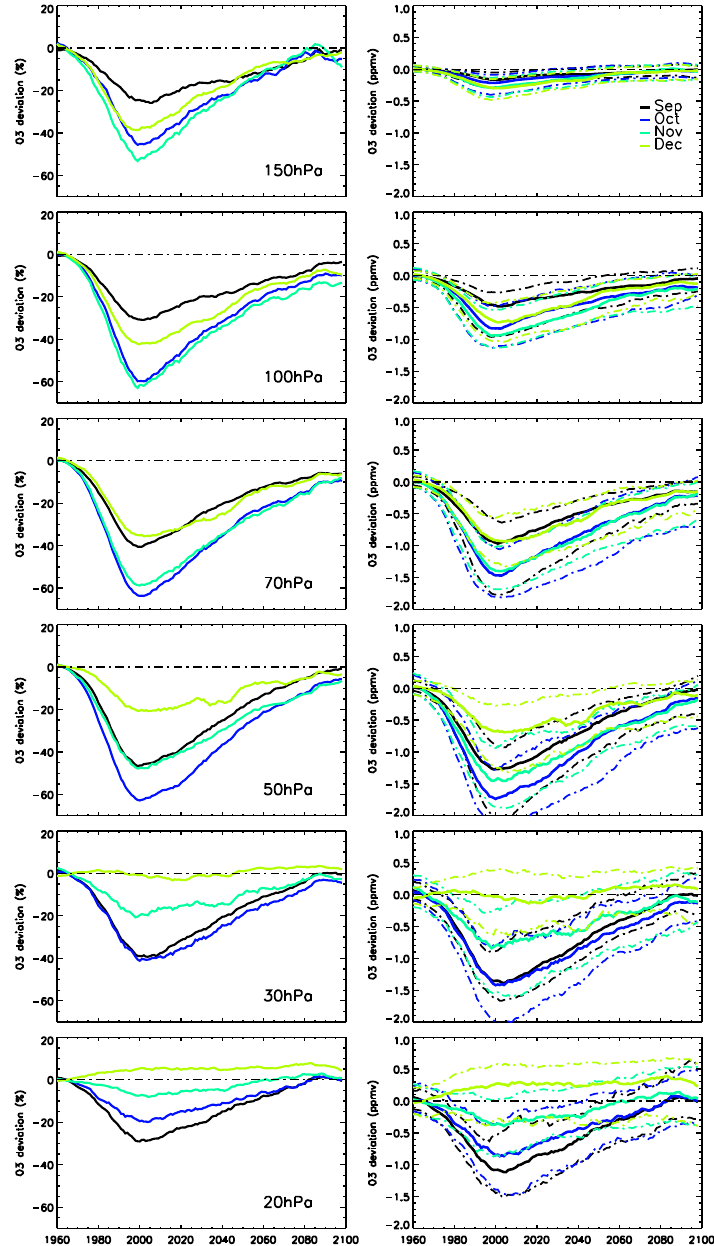
Fig. 5. Deviations of monthly multi-model median ozone VMR from 1965 baseline, zonally averaged poleward of 60 ◦ S for all available pressure levels considered by CCMVal-2 models in the range of 20–150hPa. Left panels – percent deviation from baseline, right panels – absolute deviation from baseline. Dashed lines indicate 95% confidence level of median. Model data have been smoothed with a 15yr boxcar filter.